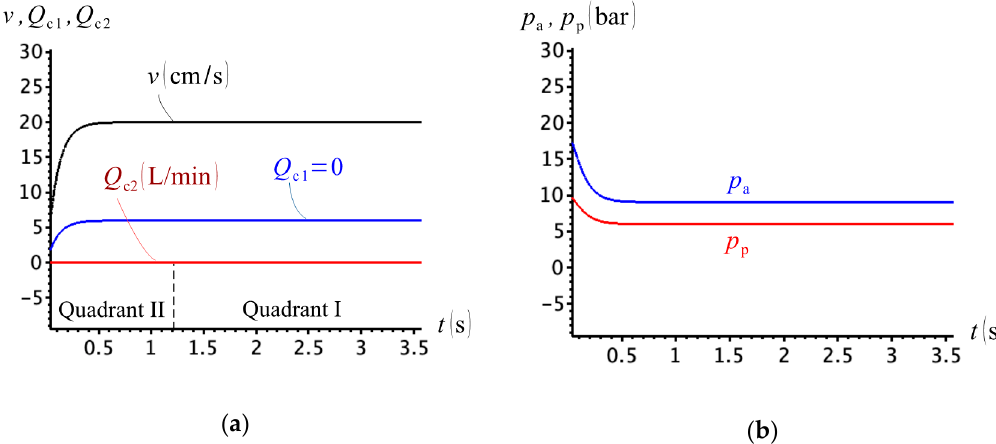
Figure 22. ( a ) Cylinder velocity and compensation flows; ( b ) cap- and rod-side pressures ( m = 0.5 kg and p cr = 0.1 bar ).